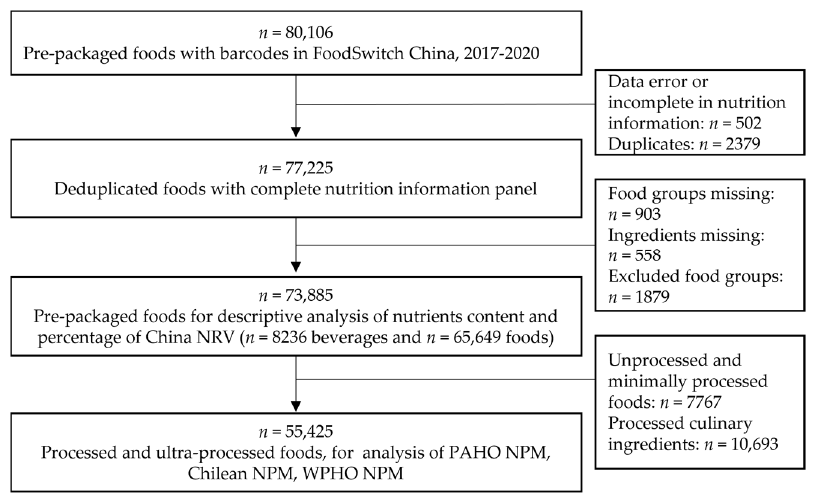
Figure 1. Flowchart of the data for analysis. NRV, nutrient reference value; NPM, nutrient profile model; WPHO, World Health Organization Western Pacific; PAHO, Pan American Health Organization.